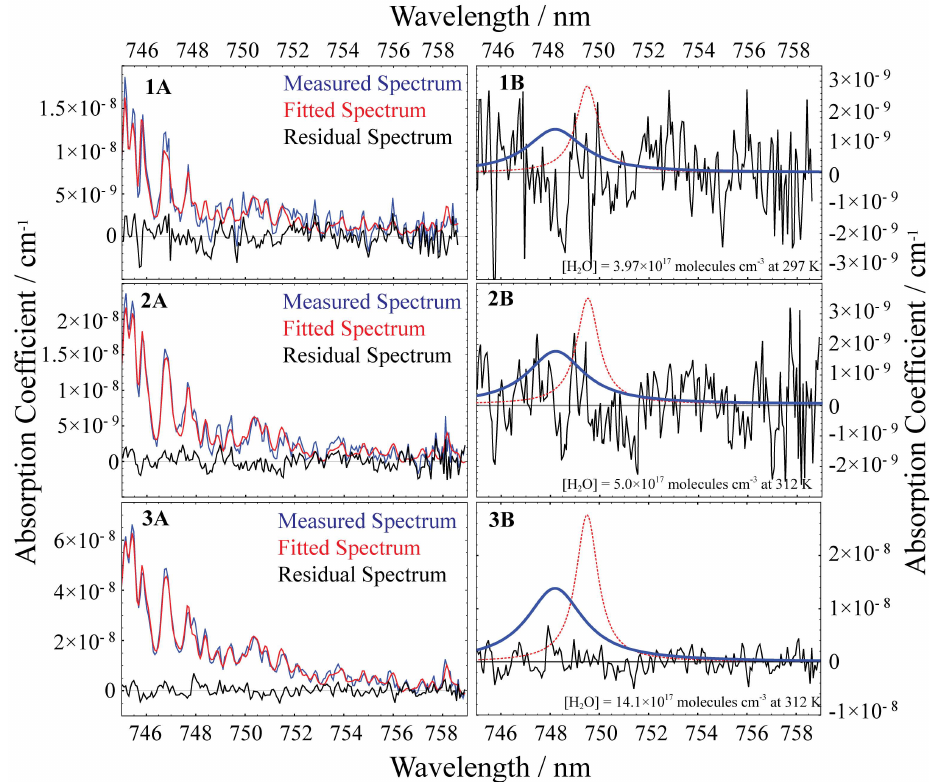
Fig. 6. Panels 1A, 2A and 3A: BBCRDS spectra (blue), corresponding fitted monomer absorption spectra (red; UCL08 line list) and residuals (measurement minus fit; black) for water monomer concentrations of 3.97 × 10 17 moleculescm − 3 at 297K, 5.0 × 10 17 moleculescm − 3 at 312K, and 1.41 × 10 18 moleculescm − 3 at 312K. Panels 1B, 2B and 3B show the residual spectra again (black), overlaid by a Lorentzian function (blue) representing a generic dimer OH b stretching band having the average line position and band intensity of the theoretical predictions shown previously in Fig. 2 (748.2nm, S=4.5 × 10 − 22 cmmolecule − 1 , 25cm − 1 HWHM). This dimer band has been assumed to scale with the square of the water monomer concentration and to scale with temperature according to the Curtiss et al. (1979) equilibrium constant. The dotted red line shows a Lorentzian function with the centre wavelength, width and intensity of the absorption feature in Pfeilsticker et al. (2003), again scaled according to [H 2 O] 2 and the K eq ( T ) of Curtiss et al. (1979). See text for further